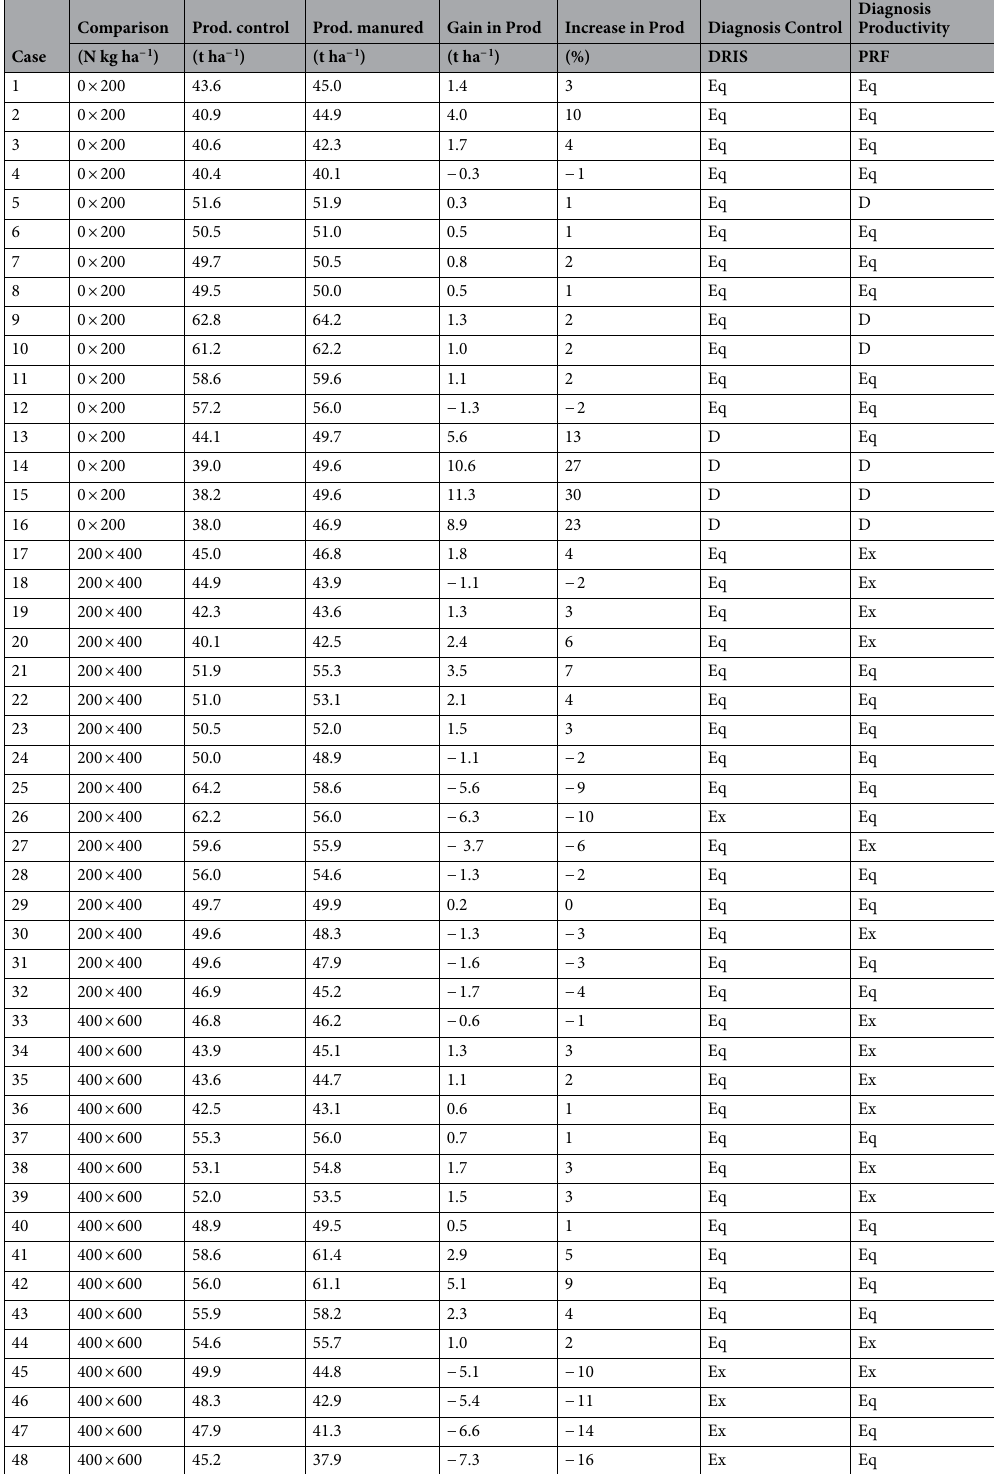
Table 3. Accuracy of nutritional diagnosis for the nutrient N for DRIS norms in banana ( Mussa spp.). N nitrogen dose, Prod average productivity, Eq nutritional equilibrium, D nutritional deficiency, Ex nutritional excess, PRF potential response to